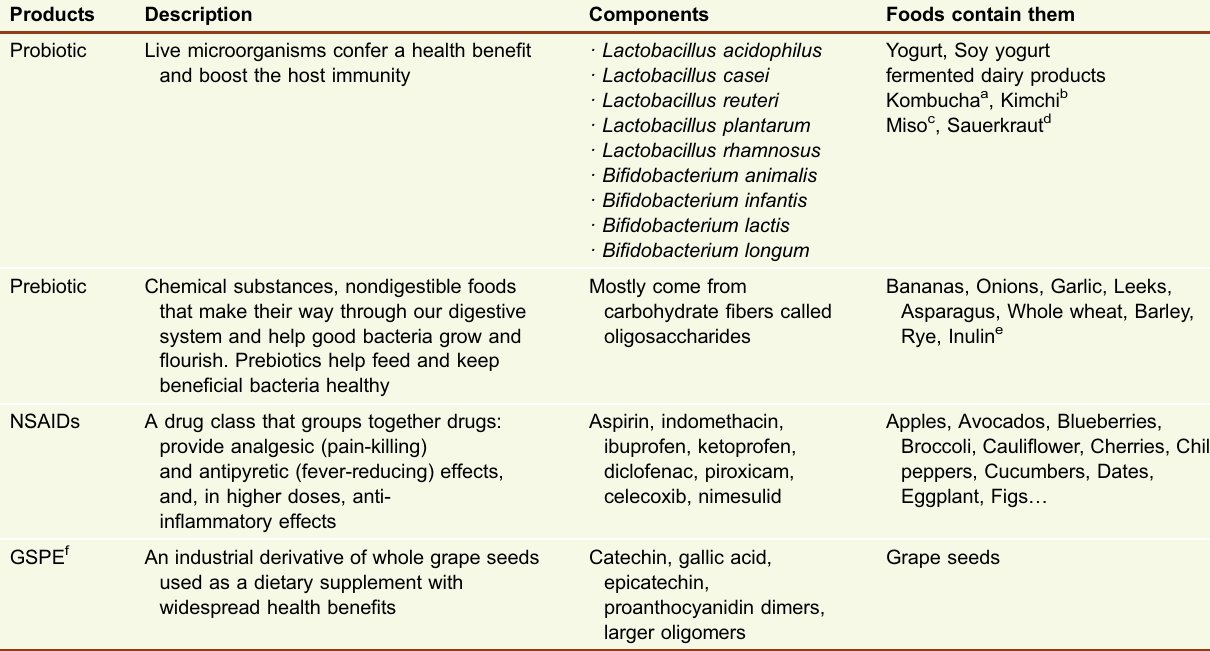
Table 2. Some methods that using to delay the process of neurodegeneration